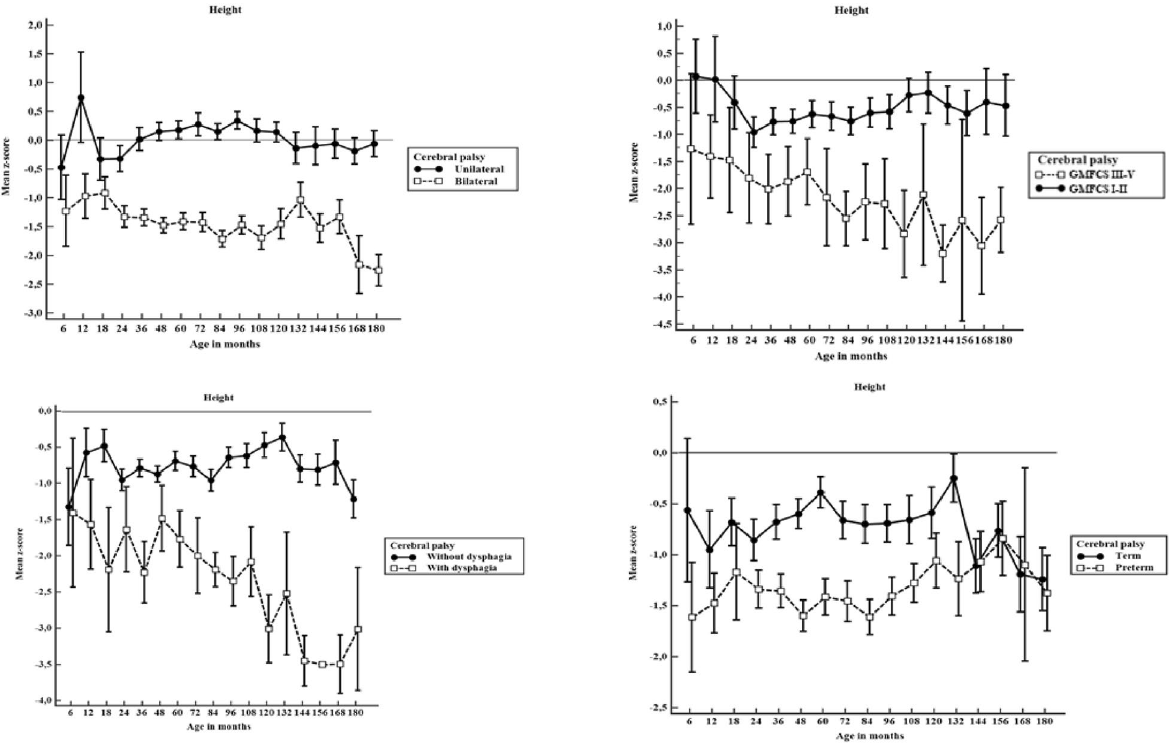
Figure 1. Height-for-age mean z-scores for with 95% CI for height by age in months among children unilateral vs. bilateral cerebral palsy, Gross Motor Function Classification System level I–II vs. III–V, with and without dysphagia and with and without prematurity (n = 1536). If the 95% CI bars overlap, the difference between the two z-score means is not statistically significant (p > Children with unilateral CP had near to normal height gain from 6 to 180 months of life with z-scores of height-for-age close to 0. Children with bilateral CP were significantly shorter than children with unilateral CP (p < 0.001). Children with GMFCS level III–V were significantly shorter than children with bilateral CP GMFCS level I–II (p < 0.001). Premature children with CP were not significantly different in height from term children with CP between 6 and 18 months (p = 0.117). From 24 to 108 months of life premature children had significantly less growth than term children with CP. After this age, the height growth is similar in both groups. Particularly interesting is the fact that term children with CP had near to normal height gain from 6 to 132 months. But at this age height z-scores dropped when compared to children with CP born premature. Children without dysphagia had close to normal height gain from 6 to 180 months of life, whereas children with dysphagia were significantly shorter (p < 0.001). Weight. Figure 2 displays estimated mean z-scores for weight with 95% CI among children with and without unilateral cerebral palsy, GMFCS level, dysphagia and prematurity. Children with unilateral CP had near to normal weight gain from 6 to 180 months of life with means of z-scores of weight-for-age of between − 0.5 to + 1. Children with bilateral CP were significantly lighter (p < 0.001). Considering GMFCS, children with levels I–II had near to normal weight gain with means of z-scores of weight-for-age of between − 0.5 to 0.5, whereas children with levels III–V were significantly lighter (p < 0.001). Premature children with CP were not significantly different in weight from term children with CP from 6 to 18 months (p > 0.05). From 24 to 108 months of life premature children had significantly less weight than term children with CP. After this age, weight gain is similar in both groups. Parallel to linear growth, term children with CP had near to normal weight gain from 6 to 132 months. But at this age weight z-scores dropped when compared to children with CP born preterm. Children with dysphagia were significantly lighter than children without this disorder, showing negative z-scores of weight-for-age (p < 0.001). Body Mass Index. Figure 3 displays estimated mean z-scores for BMI with 95% CI among children with and without unilateral cerebral palsy, GMFCS level, dysphagia and prematurity. Children with unilateral CP had near to normal BMI gain from 6 to 180 months of life, with means of z-scores of BMI-for-age of between − 0.5 and 0.5. Children with bilateral CP were significantly lower (p < 0.001).